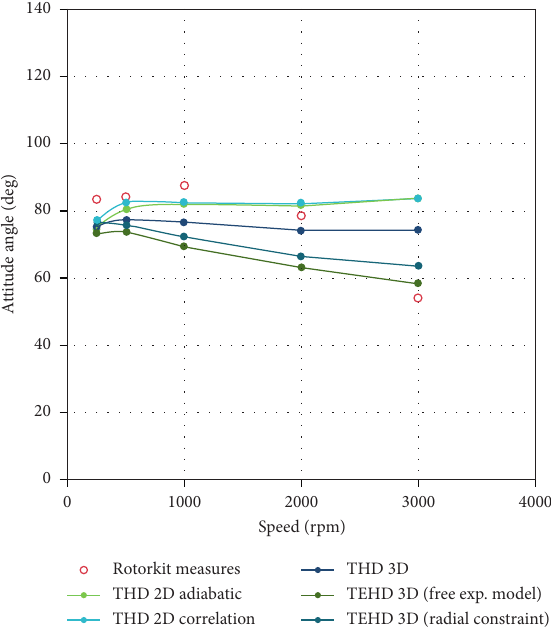
Figure 18: Attitude angle plot for the modified RK with respect to 3D numerical THD and TEHD simulation results in configuration